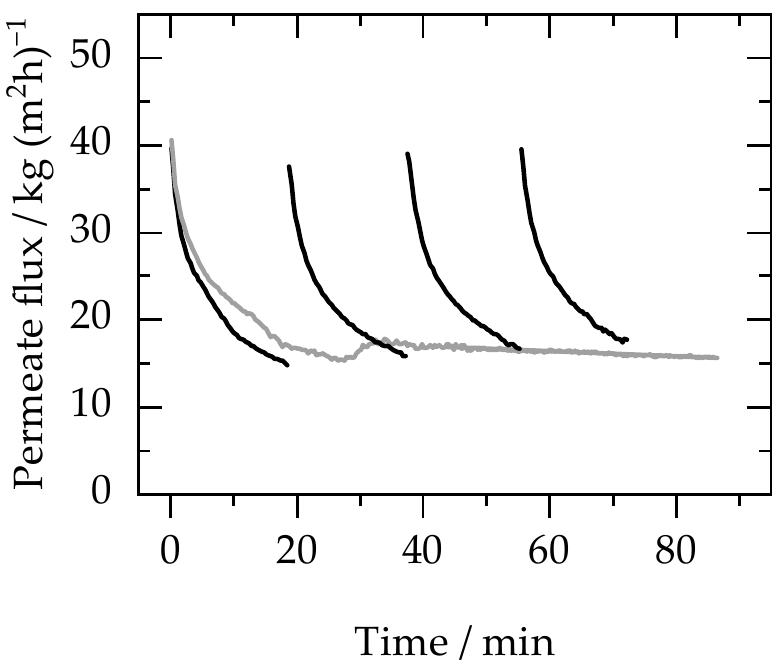
Figure 5. Permeate flux profile over time during discontinuous (black lines) and semi-continuous (grey lines) diafiltration of naproxen crystals (0.2 wt%) suspended in a solution of 0.1 wt% HPMC E3, 3.8 wt% ethanol, and 95.9 wt% water as mentioned in Table 3. The suspension used in both cases has the same composition. Experiments were conducted at 30 bar and 25 °C.